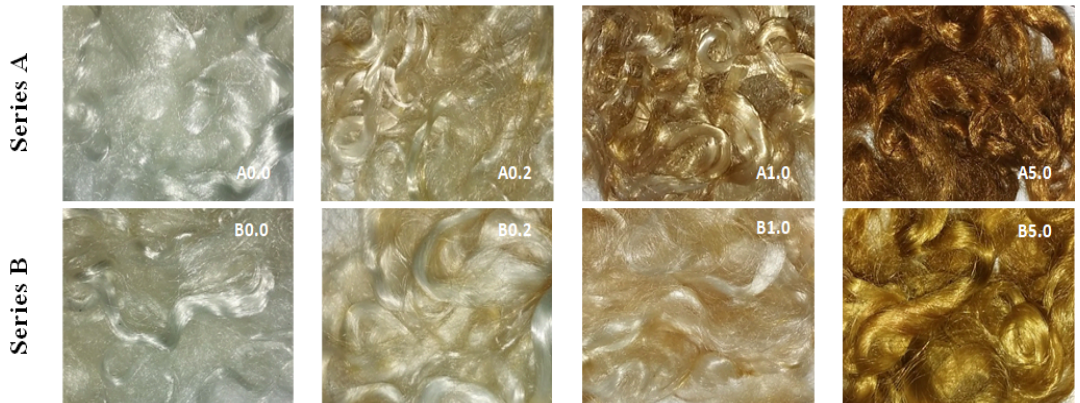
Figure 4. Digital images of fibres before and after application of theAgNO 3 .